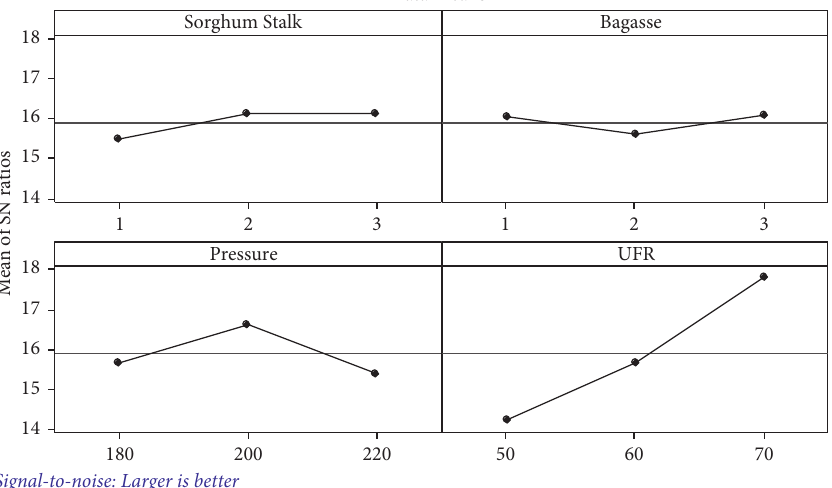
Figure 7: Main effect plot for the SN ratio for modulus of rupture (MOR). Table 8: Response for signal-to-noise ratios “larger is better” for